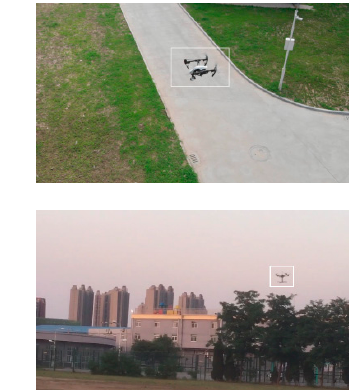
Figure 10. Training and testing results of different hidden layers: ( a ) recognition rate; ( b ) recognition time; ( c ) dimension reduction time in training by NMFsc; ( d ) dimension reduction time in testing by NMFsc; ( e ) NN training time.